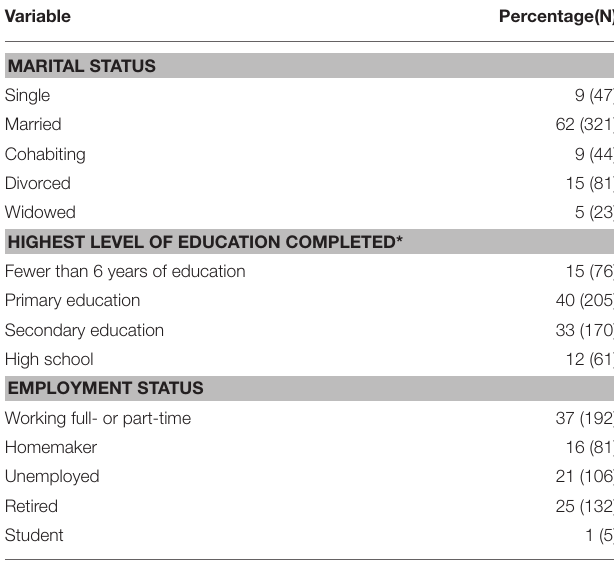
TABLE 1 | Description of the Study Sample ( N =